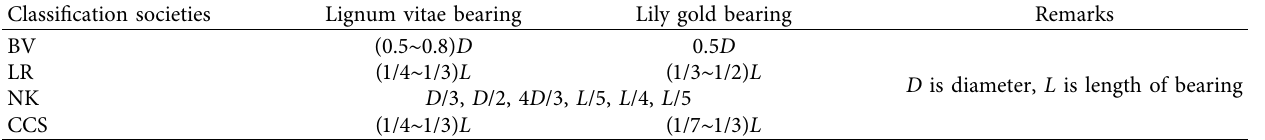
Table 3: Classification societies’ standard for simplified point support position of rear stern bearing. Classification societies